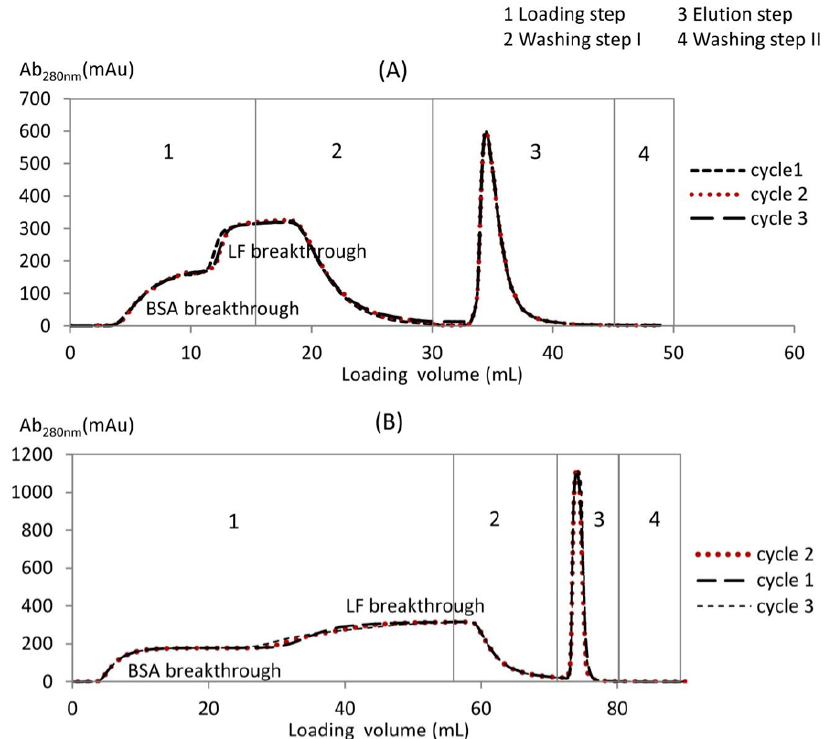
Figure 2. Three repeated cycles of BSA-LF mixture separation using for loading 100 mM phosphate buffer at pH 6.0 at a BSA-LF initial ratio of 2/1 and a flow rate of 12 bed volume BV·min −1 for ( A ) monolithic disc H = 3 mm and ( B ) membrane stack H = 3 mm in the CIM housing. Afterward, the membrane or monolith reached saturation, and the LF breakthrough curve